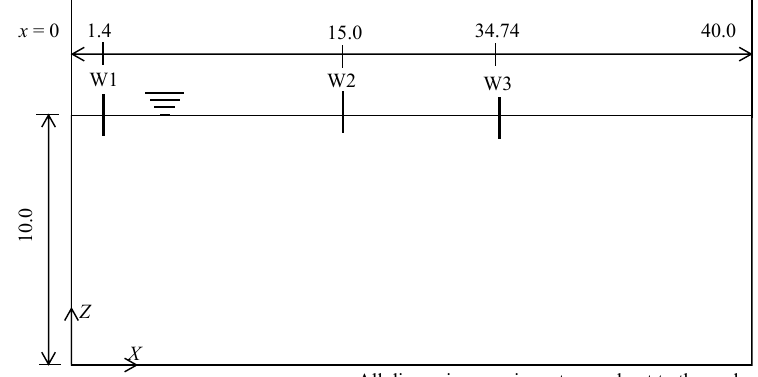
Figure 9. Numerical wave tank setup for simulating the experiments performed by Pákozdi et al. [39] (side-view).